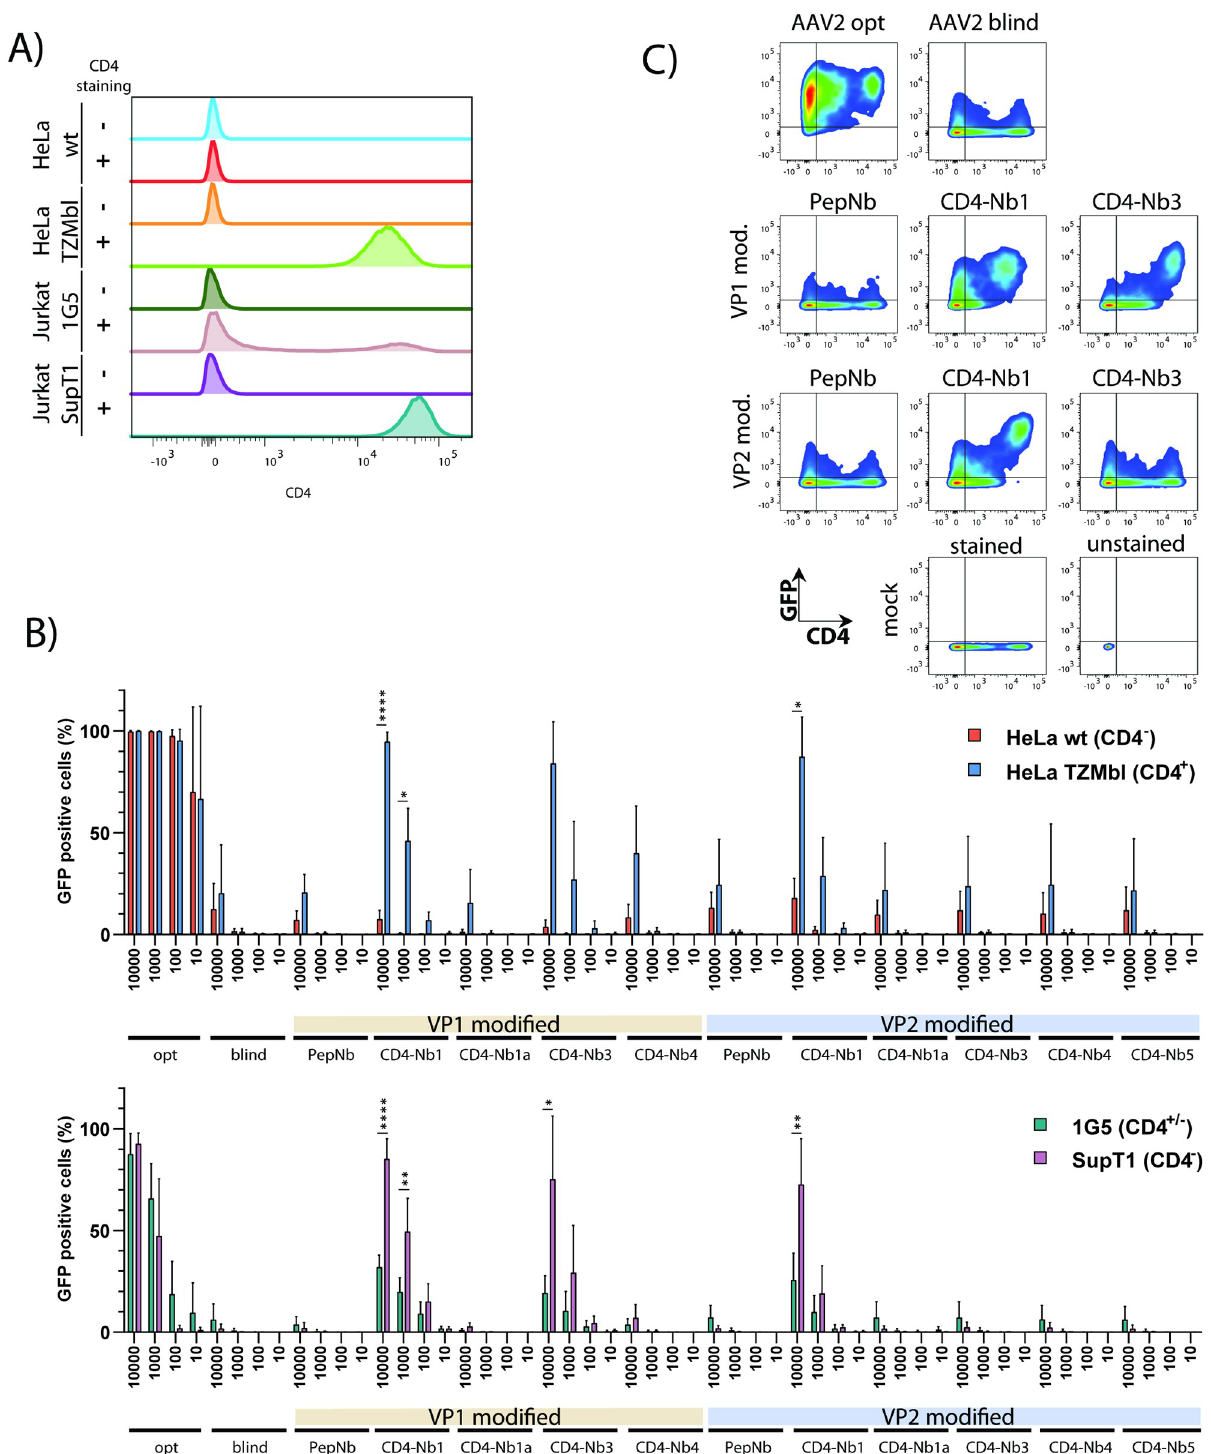
Fig 3. AAV2 CD4-Nb-containing particles efficiently transduce CD4 expressing cells. (A) CD4 expression on cell lines used in this study. Cells were stained with anti-CD4-Cy7 antibody and compared to unstained mock controls. The CD4 signal in mock cells was manually adjusted to 100 arbitrary units and compared with stained cells by flow cytometry. Histograms were normalized by modal mode to visualize comparable peak heights. (B) Two HeLa (wt and TZMbl) and two T lymphoid (1G5 and SupT1) cell lines were transduced with the indicated viral vector genome copies per cell (gc/cell). Three days post infection the % of eGFP positive cells was determined by flow cytometry; n = 2–4. Error bars indicate the SD. (C) 1G5 cells were